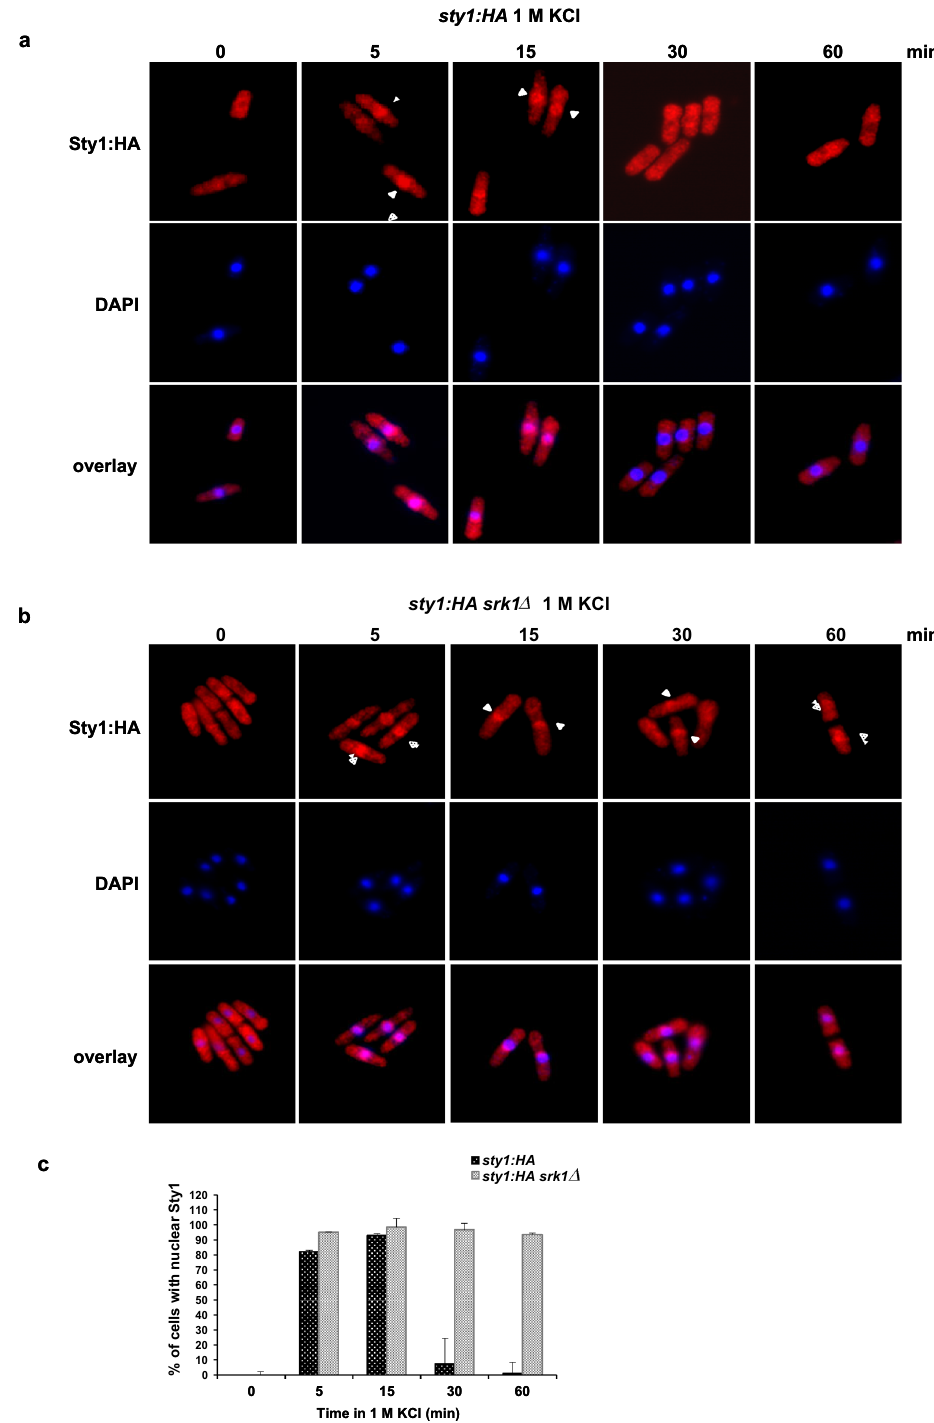
Figure 4. Sty1 localization in response to stress is altered in absence of Srk1. Wild-type ( a ) and srk1∆ ( b ) cells expressing genomic sty1:HA were grown in YES medium to mid-log phase, remained untreated (0 min) or treated with 1 M KCl, and fixed with methanol at the indicated times. Sty1 localization was detected by indirect immunocytochemistry with anti-HA primary antibody (upper panels) and nuclei were stained with DAPI (middle panels). An overlay of both is shown in the lower panels. ( c ) Cells with Sty1 localized in the nucleus, in sty1:HA and sty1:HA srk1 Δ cells treated with 1 M KCl at indicated times, were quantified. Data represent the average of two biological